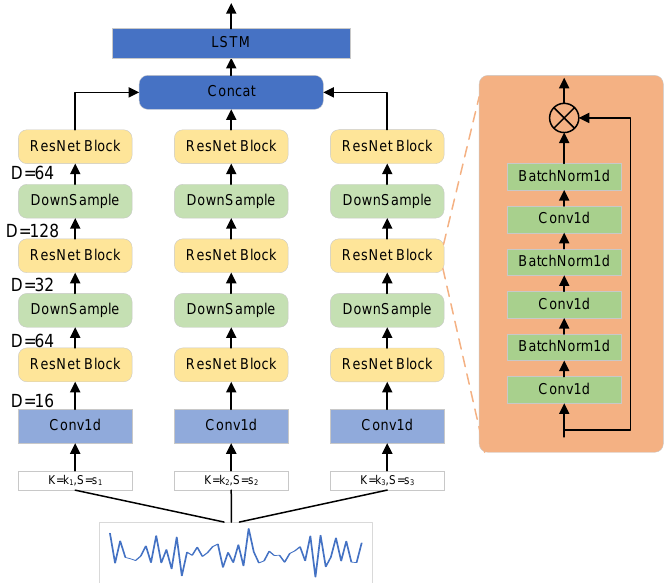
Figure 4. Time-domain feature extraction module. The nine residual blocks have the same composi- tion and all consist of BottleNeck structures, where the three convolution kernels are of sizes 1, 3, and 1. The D in the figure indicates the data dimension of the corresponding